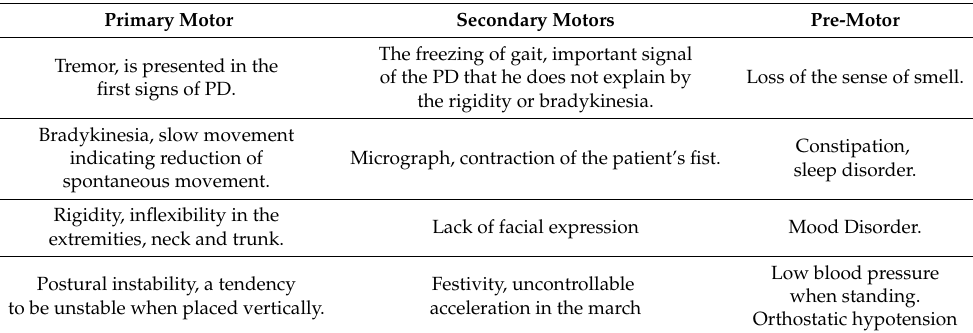
Table 1. Motor and non-motor symptoms of Parkinson’s